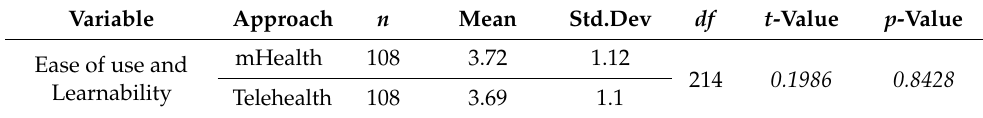
Table 5. Difference in ease of use and learnability of mHealth and